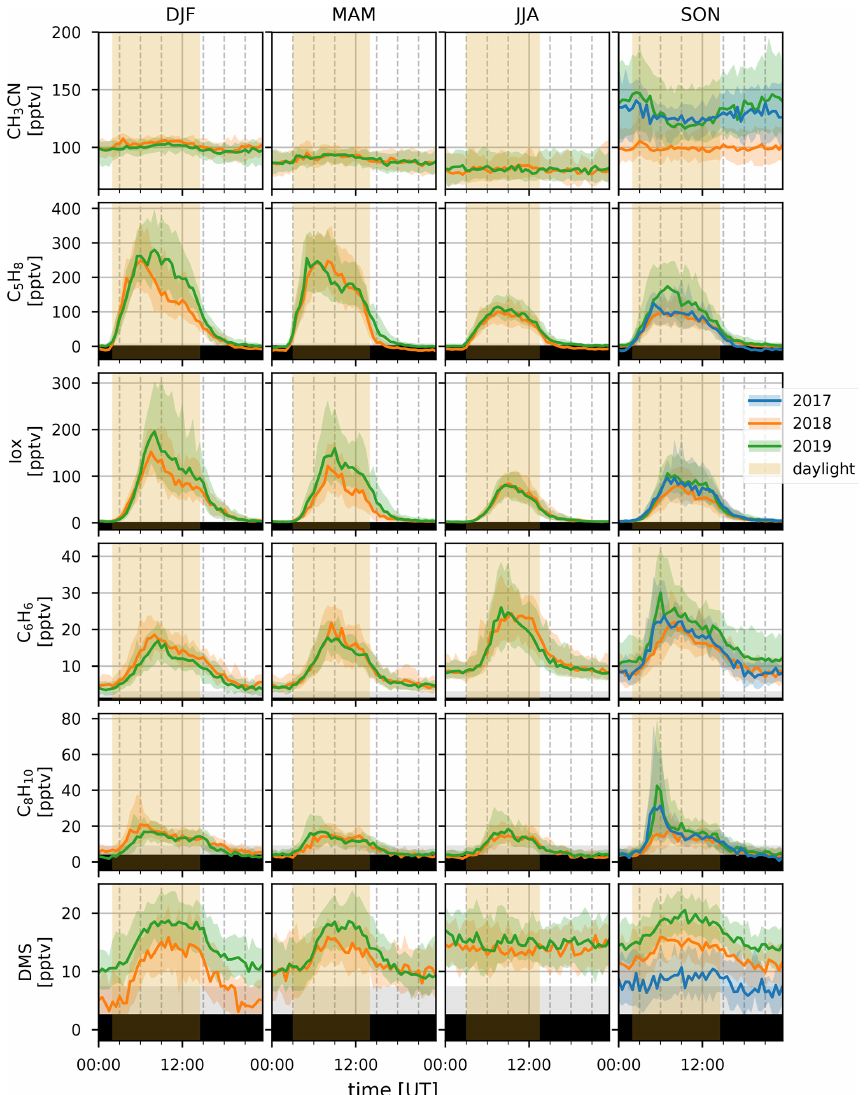
Figure 3. Median diel profiles (lines) and the interquartile distance (shaded area) for the DJF, MAM, JJA, and SON seasons (columns, left to right) in 2017, 2018, and 2019 (blue, orange, and green curves, respectively) for CH 3 CN, C 5 H 8 , Iox, C 6 H 6 , C 8 H 10 , and DMS (rows, top to bottom). The yellow shaded area illustrates daylight during the respective seasons. Gray background shows the range between the median limit of detection and the minimum limit of detection of half-hour measurements. Individual half-hour measurements in the black region of the plots are not